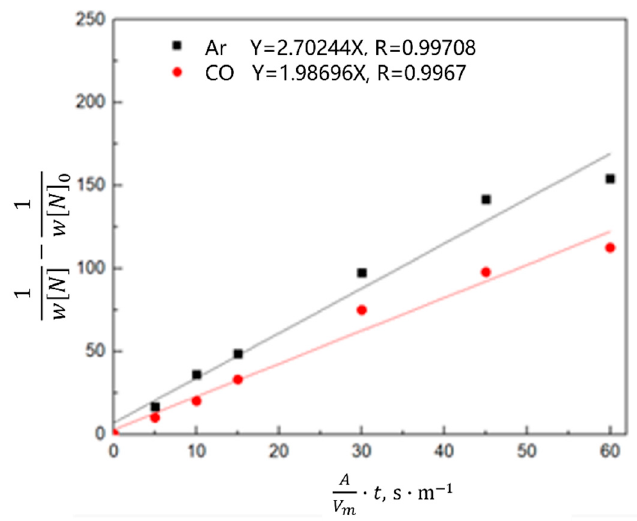
Figure 19. Kinetic law of nitrogen absorption by molten steel with a 0.026% oxygen content and different gases.